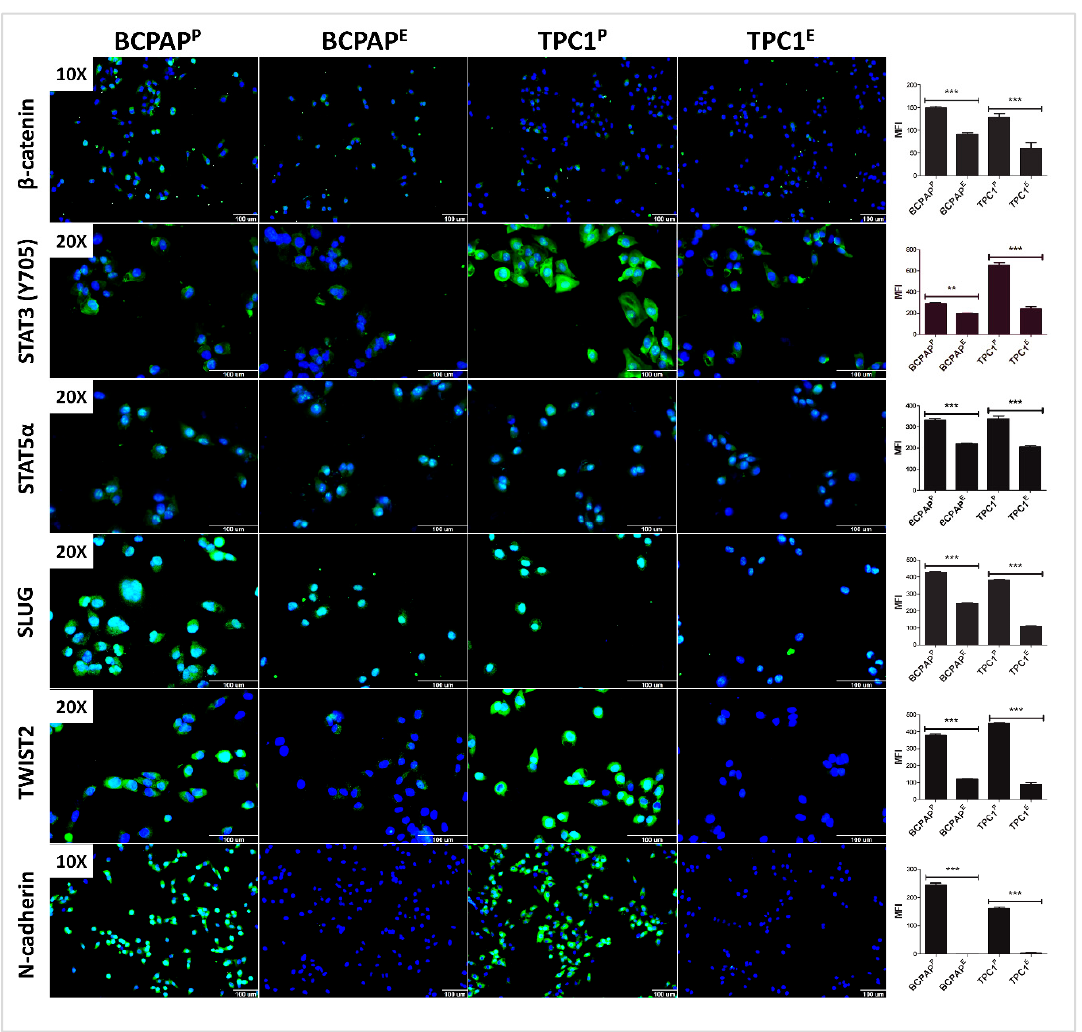
Figure 9. Results of immunodetection of β -catenin, STAT3 (Y705), STAT5 α , SLUG, TWIST2, and N- cadherin by high-content screening. Results show a significant downregulation of all analyzed proteins in both edited cells and the absence of nuclear immunodetection of STAT3 (Y705) and SLUG in BCPAP E and TPC1 E cell lines. Scale bar of 100 µm. *** p < 0.001 and ** p <